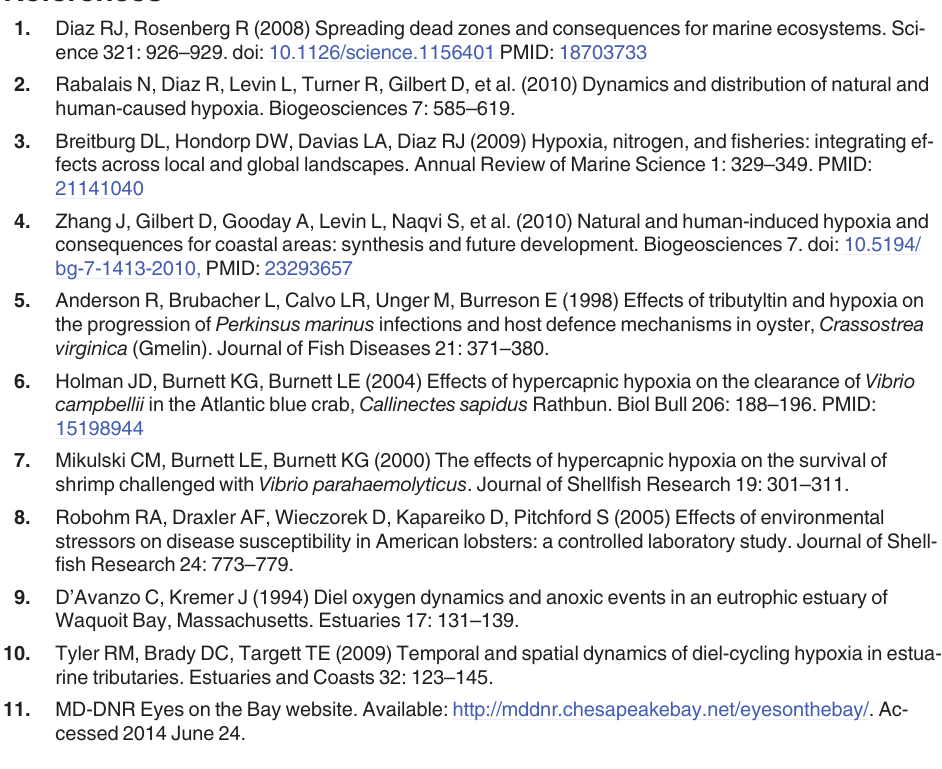
S1 Table. Locations of experimental oyster deployments in 2008 – 09. Numbers correspond to the site code in Fig. 1 in the main manuscript and S1